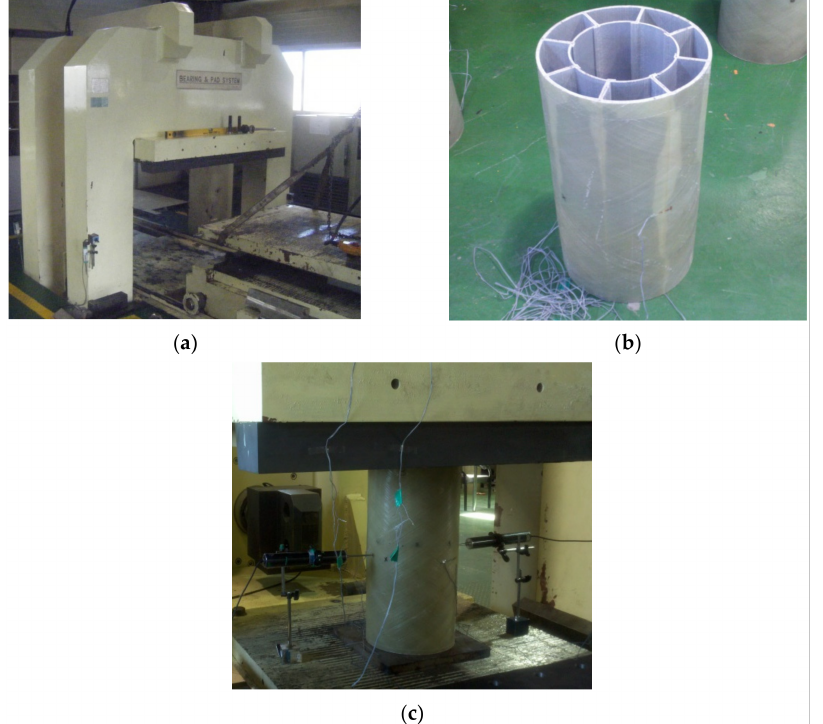
Figure 8. Compressive strength experiment of PFRP − FFRP. ( a ) Compression tester with a capacity of 30,000 kN. ( b ) Experimental PFRP-FFRP specimen of ϕ 300 × 600. ( c ) Experimental test